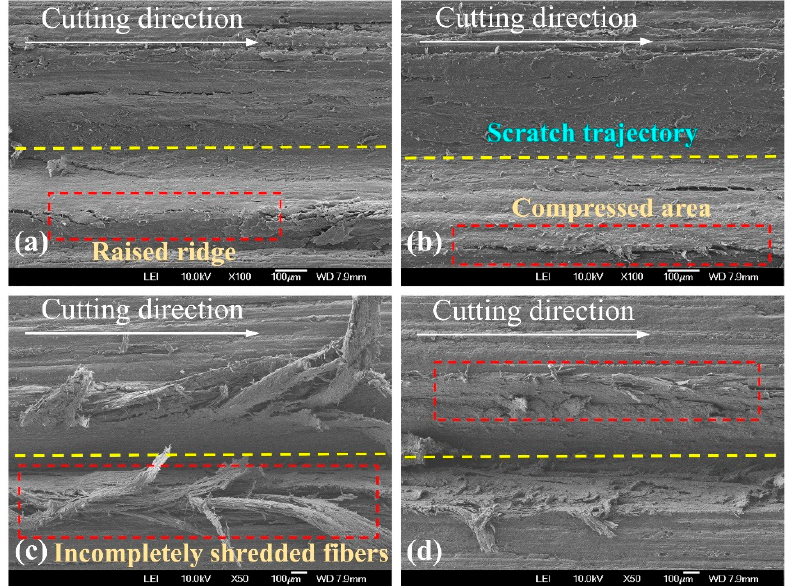
Figure 5. SEM ( scanning electron microscope) micrographs of typical scratches ( λ = 0 ° ) cut by: ( a ) spherical cone tool with 2 α = 84 ° , ( b ) spherical cone tool with 2 α = 108 ° , ( c ) triangular pyramid tool with one main cutting edge and two side cutting edges, and ( d ) triangular pyramid tool with two main cutting edges.